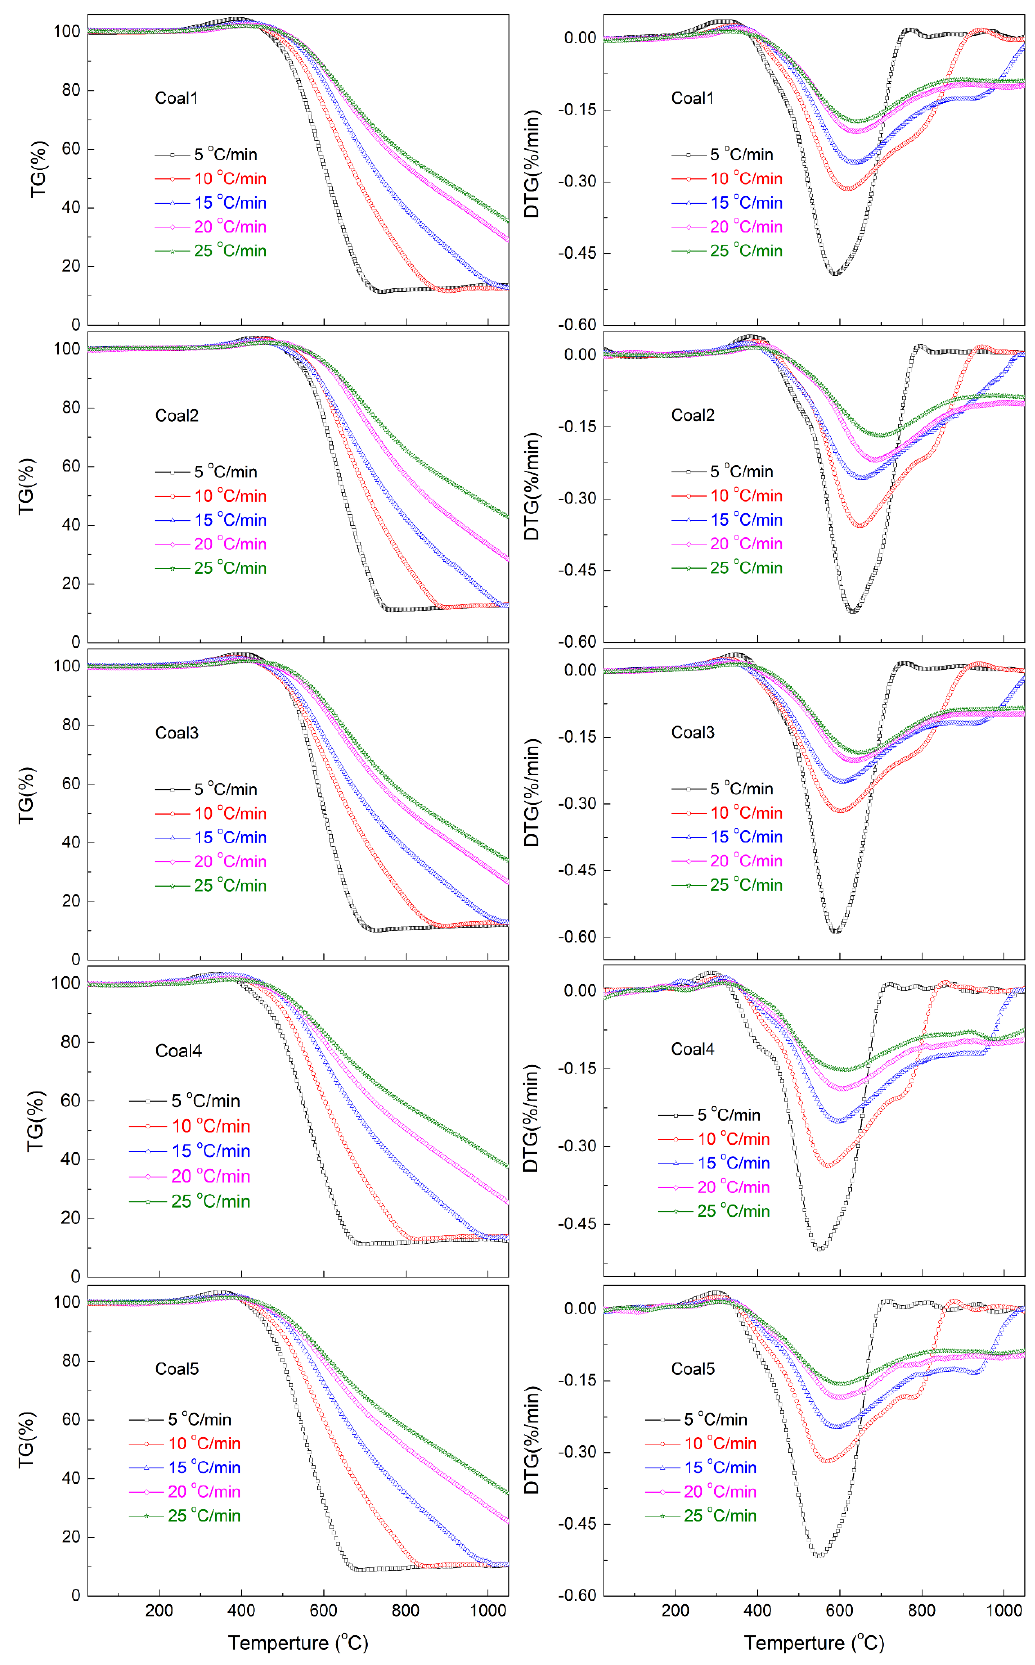
Figure 6. TG and DTG curves of bituminous coal samples.